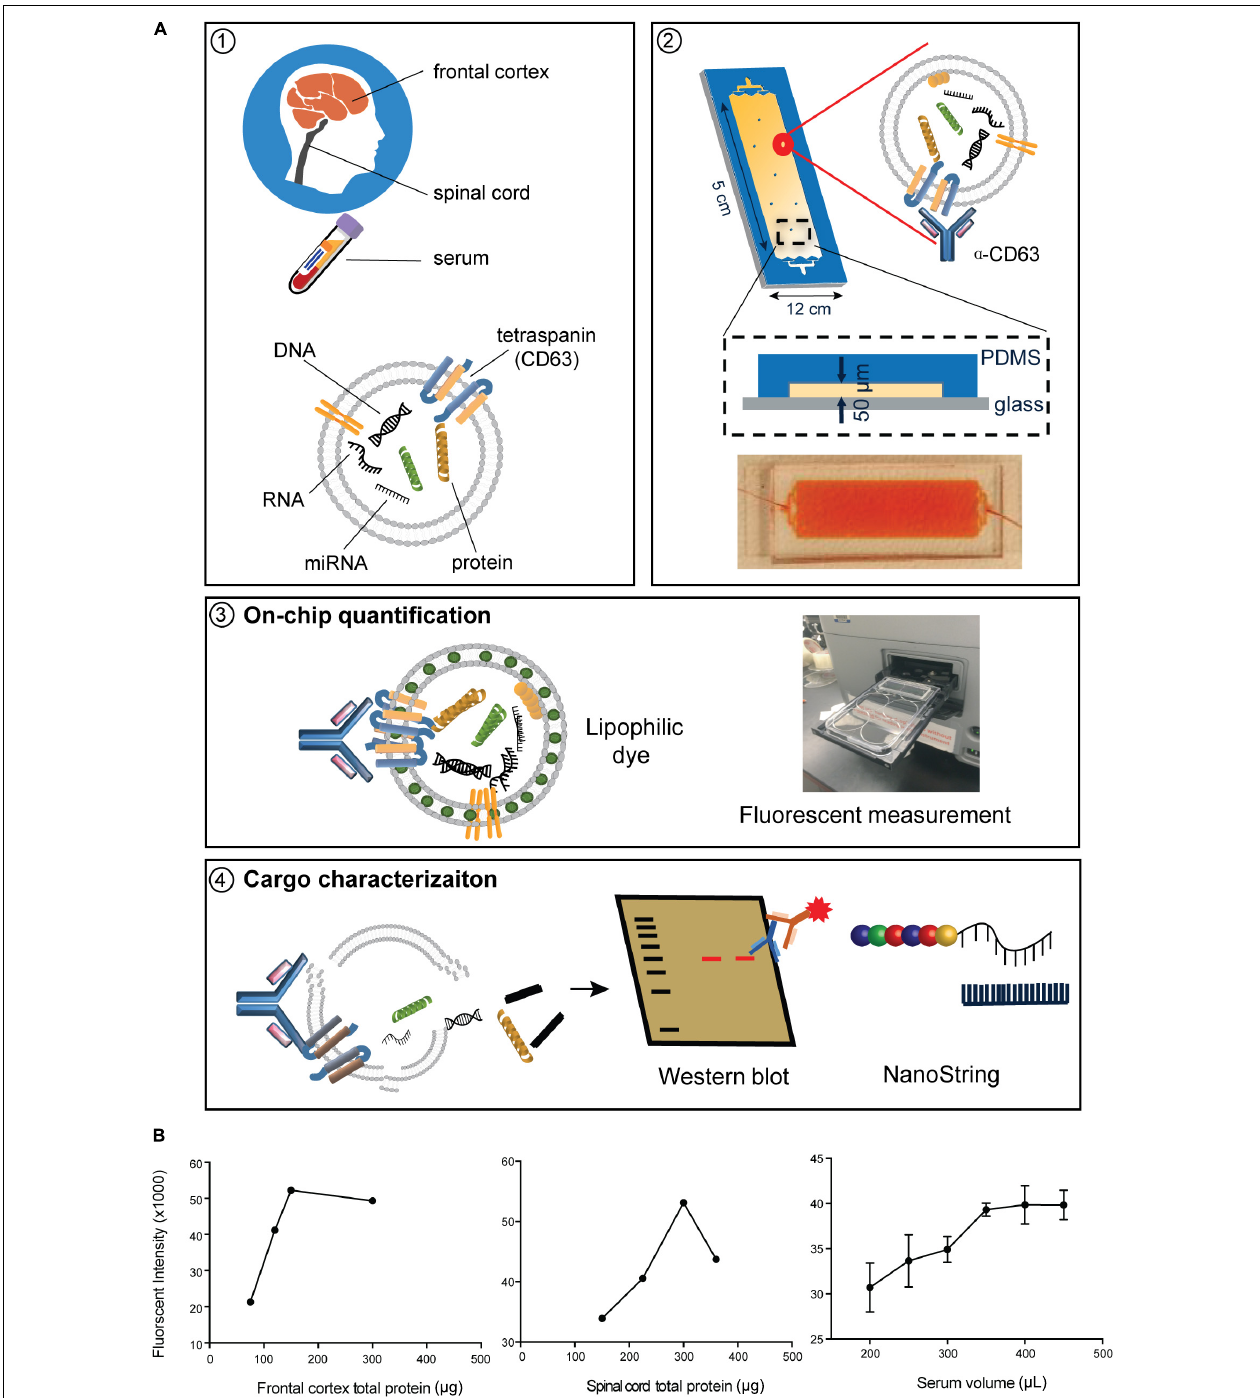
FIGURE 1 | Immuno-affinity-based microfluidic EV isolation from ALS tissue. (A) Workflow for immobilizing and characterizing EVs. (1) EVs were captured from frontal cortex, spinal cord, and serum from ALS or control participants by a (2) CD63-antibody-coated ExoChip. (3) To quantify the captured EVs, the chip was processed with lipophilic (DiO) staining, and measured fluorescence intensity was normalized to background and correlated to the amount of fluorescently stained EVs. (4) Immobilized EVs were lysed for Western blotting and cargo profiling by NanoString. (B) Verification of the saturation capacity of the ExoChip device for serum and tissue homogenates. For frontal cortex and spinal cord, testing of 300 µ L of homogenates with various total protein concentrations revealed a saturation concentration of 0.5 µ g/ µ L for frontal cortex and 1 µ g/ µ L for spinal cord tissue. For serum, the device reaches maximum fluorescence intensity when the volume of serum equals 400 µ L. Data are presented as mean ± standard error of the mean (s.e.m.) ( n =